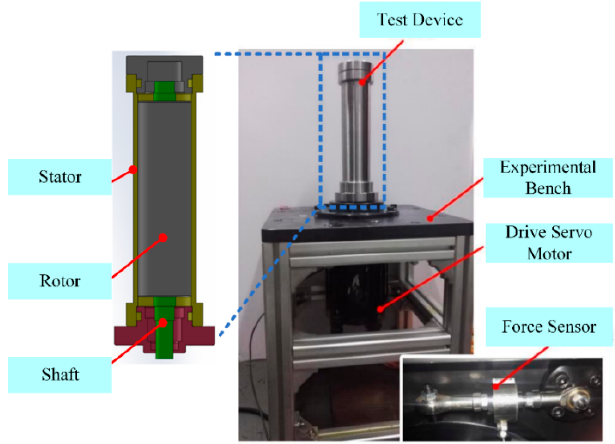
Figure 8. Test rig that was used to conduct the experiments of this research.